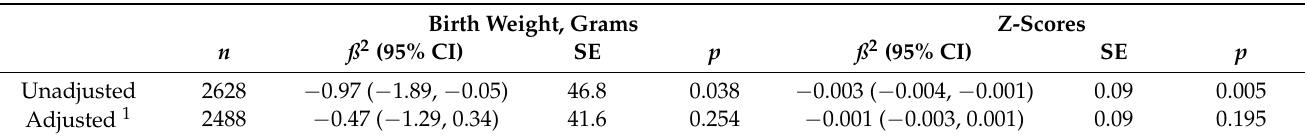
Table 6. Associations between maternal selenium concentration in whole blood and birth weight in 2628 women from the Norwegian Mother, Father and Child Cohort